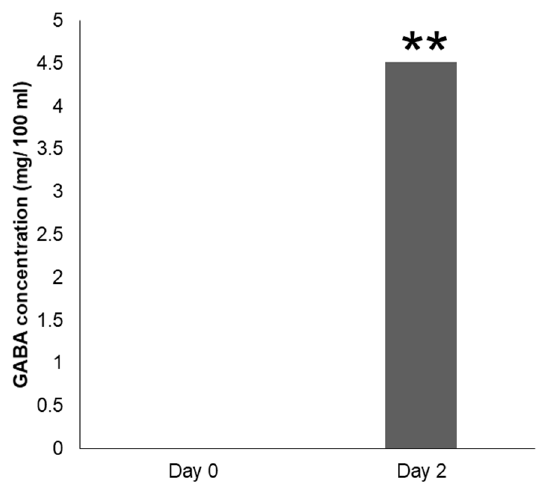
Figure 12. Concentration of GABA of the GMSFS treated by strain N10 for 2 days ( n = 3). Asterisks mean significant difference ( p < 0.01).